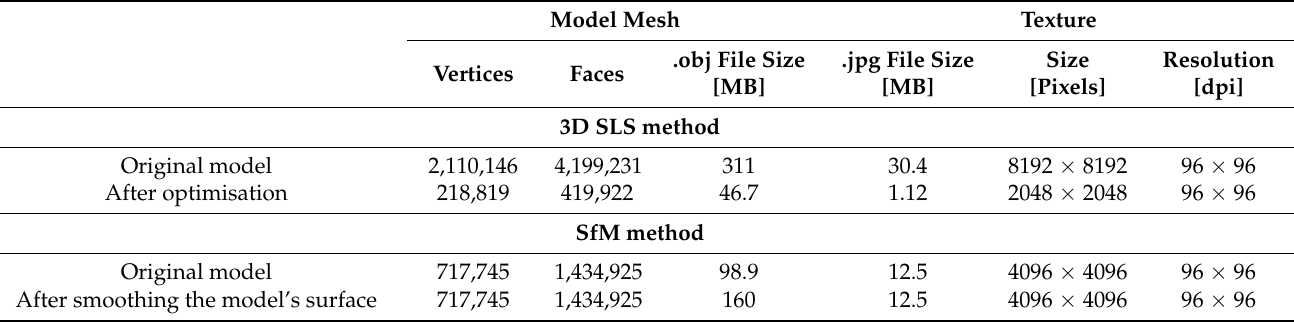
Table 5. Parameters of the digital 3D model and the texture of the